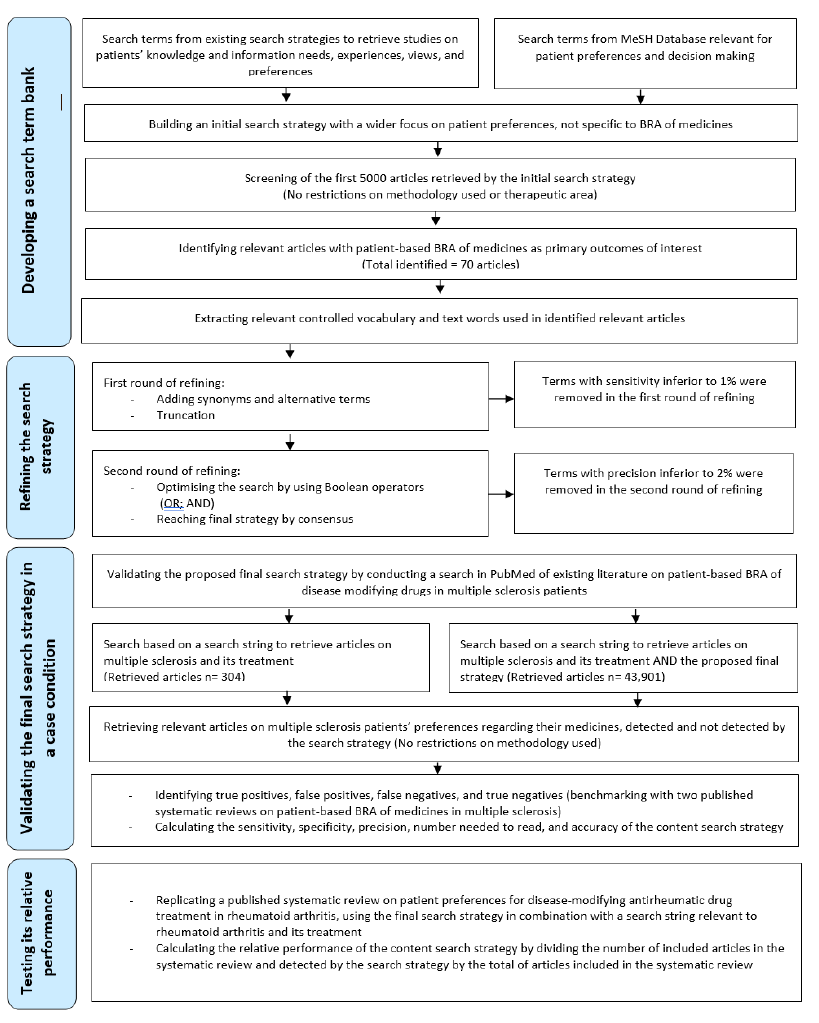
Figure 1 Flow diagram depicting the iterative process of developing a search term bank, refining the search strategy, and then validating the final